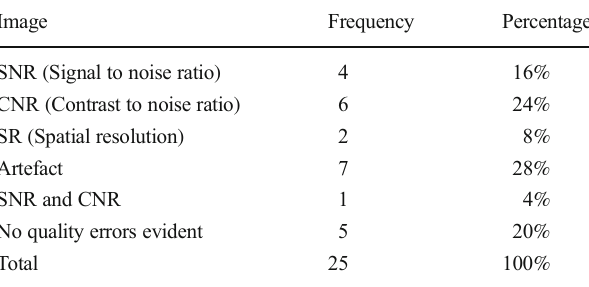
The percentage of images within the MR image dataset